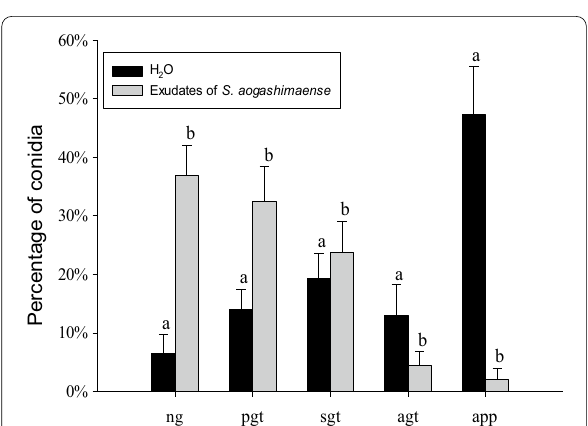
Fig. 5 Suppression effects of Simplicillium aogashimaense exudates on developmental processes of Blumeria graminis